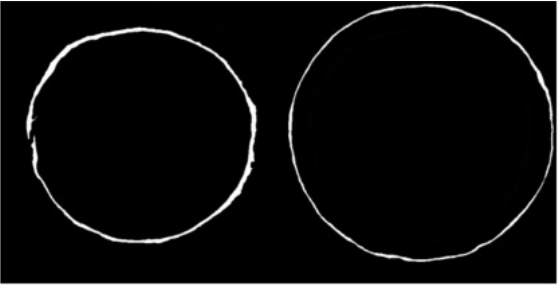
Figure 9. Image after corrosion.